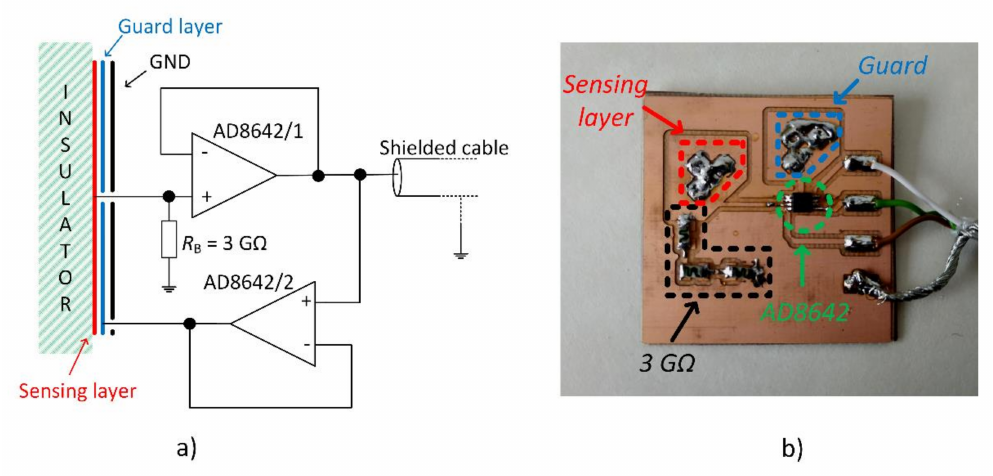
Figure 3. Schematic ( a ) and design ( b ) of the constructed active electrode. Reprinted with permission from ref. [16]. Copyright 2019 Elsevier